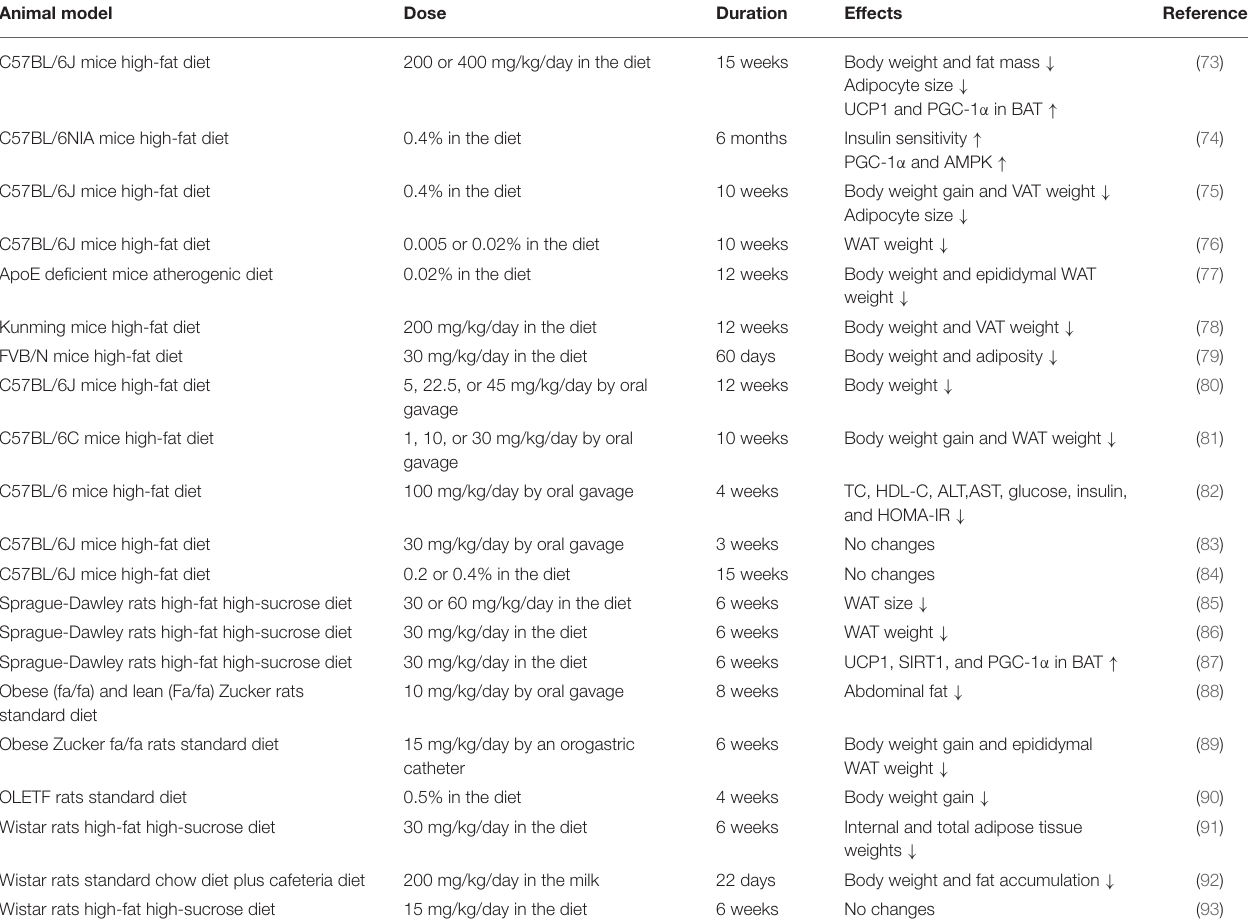
TABLE 1 | Animal studies related with the anti-obesity benefits of